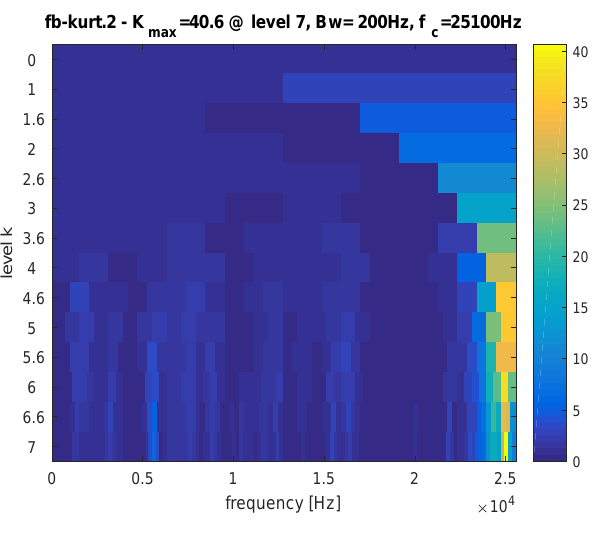
Figure 17: Resulting kurtogram. Table 1: Operator settings for the test ( n c = 6). Conf.